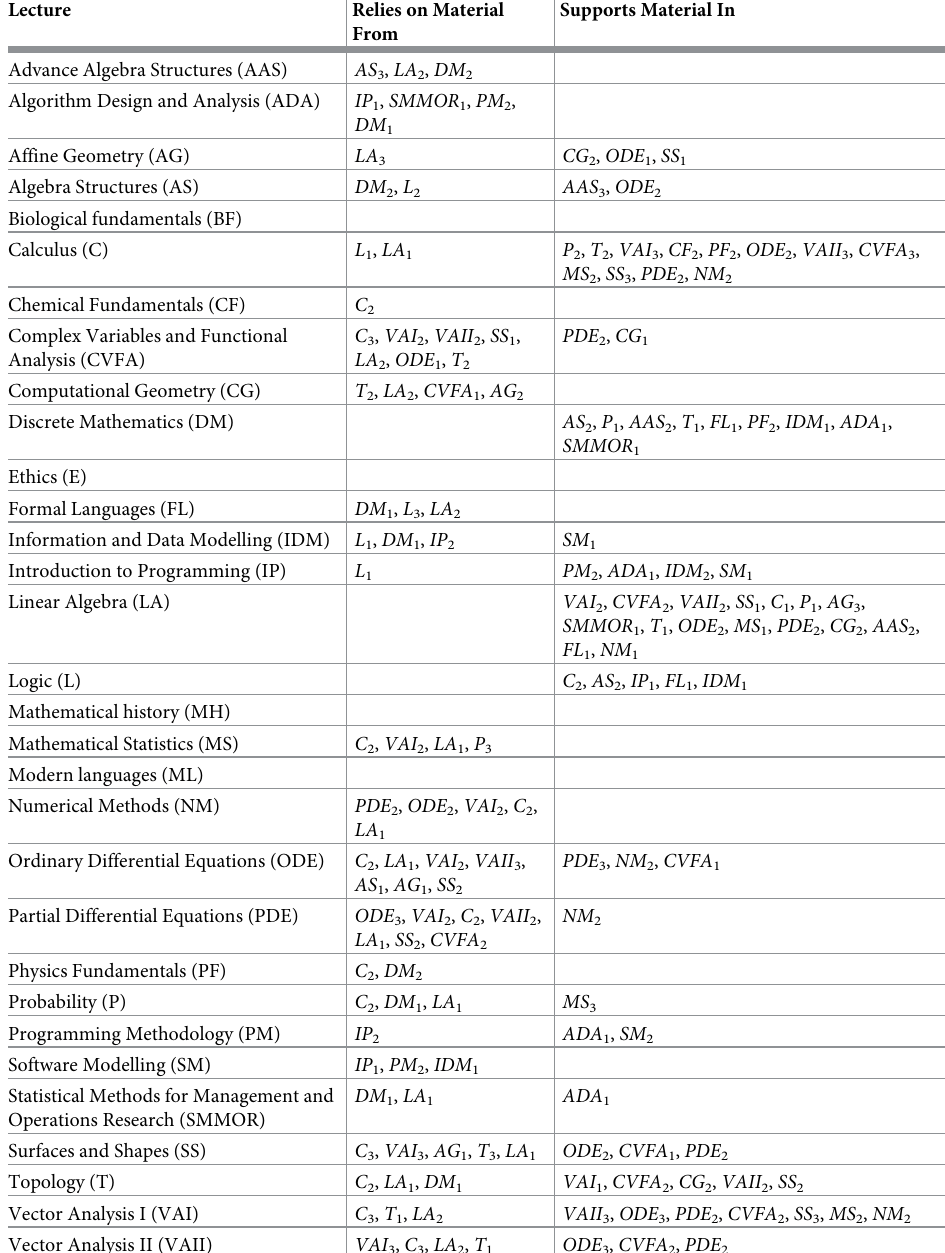
Table 1. Influences between the different courses in the mathematics degree in the URJC and level of dependency. Lecture Relies on Material Supports Material In From Advance Algebra Structures (AAS) AS 3 , LA 2 , DM 2 Algorithm Design and Analysis